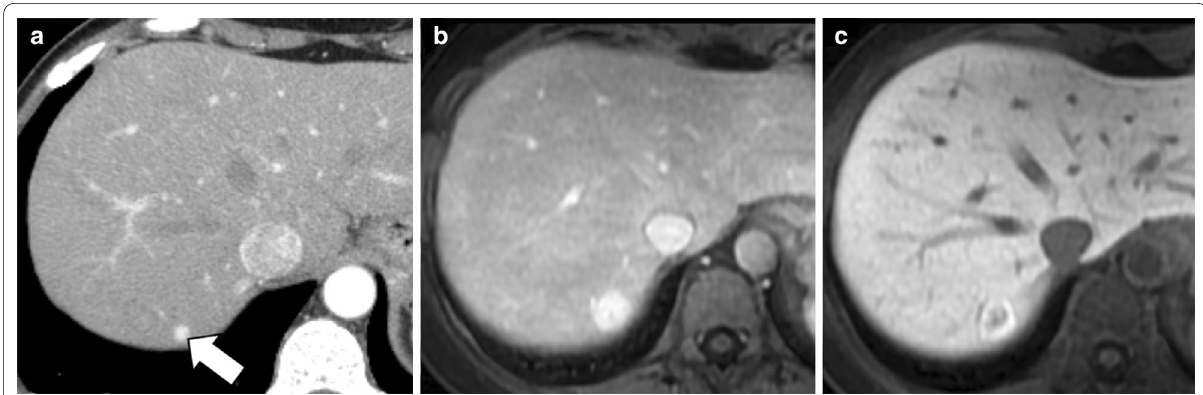
Fig. 8 A 40‑year‑old woman with sigmoid adenocarcinoma and liver metastases treated with chemotherapy (XELOX regimen). a Contrast‑enhanced CT shows a FNH‑like nodule (arrow) that is hypervascular in the arterial phase. Gadoxetate disodium‑enhanced MRI performed 2 years later ( b ) in the arterial phase and ( c ) hepatobiliary phase shows size increase which raises the suspicion of metastasis. However, the hepatobiliary phase ( c ) demonstrates a hyperintense rim establishing the diagnosis of FNH‑like nodule